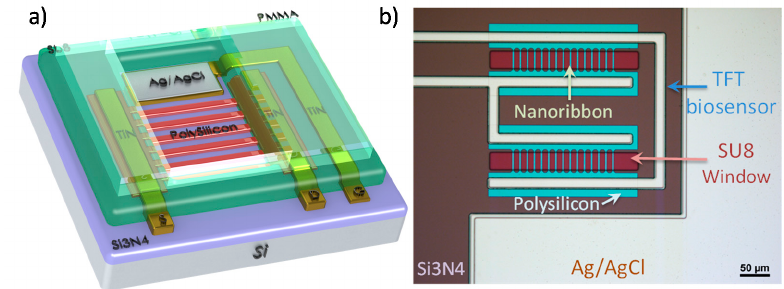
Figure 1. ( a ) Three-dimensional representation of the TFT nanoribbon biosensor; ( b ) Microscope picture of the TFT nanoribbon biosensor.